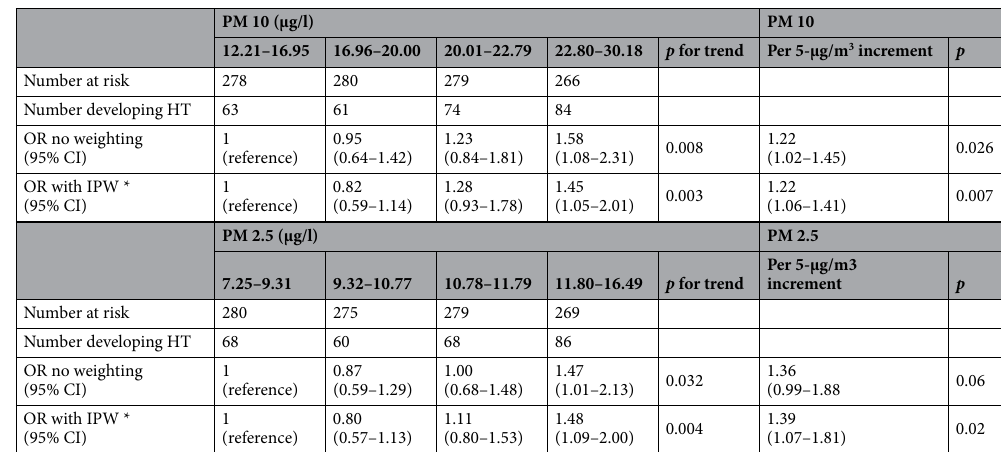
Table 3. Incidence rates and crude and multivariate adjusted odd ratios for developing hypertension according to PM 10 and PM 2.5 concentrations during follow-up (2008–2016). CI, confidence Interval; HT, hypertension; IPAQ, international physical activity questionnaire; IPW, inverse probability weighting. MedScore, mediterranean diet score; PM 10 , particles with an aerodynamic diameter of less than 10 µm; PM 2.5 , particles with an aerodynamic diameter of less than 2.5 µm; OR, odds ratio. *Inverse probability weighting (IPW) using as confounding variables age, gender, ethnicity, education level, MedScore, IPAQ, alcohol intake, smoking, BMI, BP levels at baseline, Ambient temperature and Humidity.